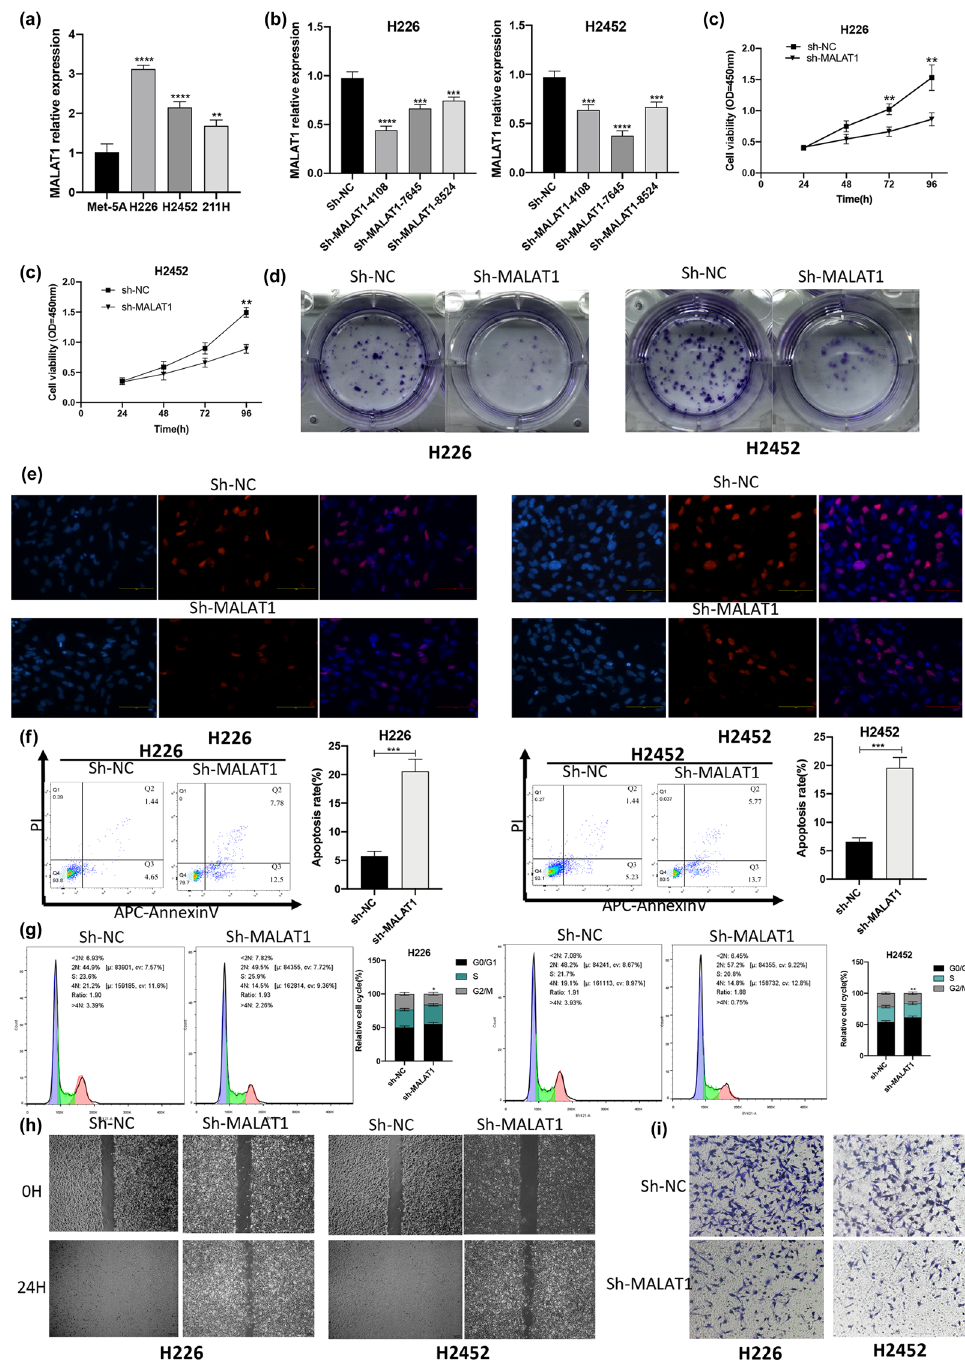
Figure 1: lncRNA MALAT1 is overexpressed in MPM cell lines. Knockdown of MALAT1 inhibits the proliferation, migration, and invasion of MPM cells, and induces the cell apoptosis. ( a ) The expression level of MALAT1 in human MPM cell lines ( H226, H2452, and MSTO - 211H ) and normal human epithelial cell lines ( Met - 5A ) was detected by RT - qPCR ( ** P < 0.01, **** P < 0.0001 vs Met - 5A group, one - way ANOVA and SNK - Q tests ) . ( b ) The knockdown e ffi ciency of sh - MALAT1#4108, sh - MALAT1#7645, and sh - MALAT1#8524 in H226 and H2452 cells was assessed by RT - qPCR ( *** P < 0.001, **** P < 0.0001 vs Sh - NC group, one - way ANOVA and SNK - Q tests ) . ( c ) The in fl uence of sh - MALAT1 on the cell viability was detected by CCK - 8 ( ** P < 0.01, t - test ) . ( d ) The e ff ect of sh - MALAT1 on the cell proliferation was evaluated by colony formation assay. ( e ) The e ff ect of sh - MALAT1 on the cellproliferationwasassessedbyEdUassay. ( f ) Thee ff ectofsh - MALAT1onthecellapoptosiswasdeterminedby fl owcytometry ( *** P < 0.001, t - test ) . ( g ) Flow cytometry detected the in fl uence of sh - MALAT1 on the cell cycle progression ( * P < 0.05, ** P < 0.01, chi - square test ) . ( h ) The e ff ect of sh - MALAT1onthecellmigrationwasdeterminedbyscratchtest. ( i ) Thee ff ectofsh - MALAT1onthecellinvasionwasinvestigatedbyTranswellinvasion assay. RT - qPCR, quantitative reverse transcription polymerase chain reaction; NC, negative control; sh - RNA, short hairpin -